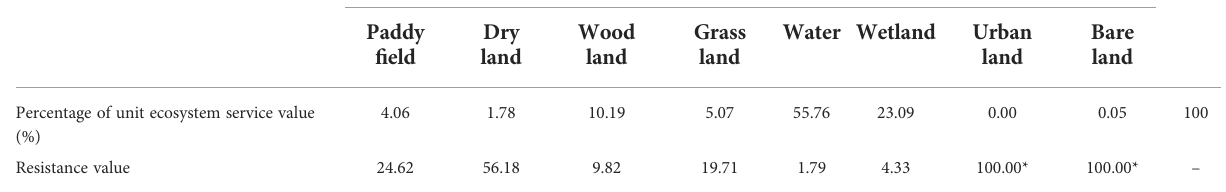
TABLE 4 Landscape ecological resistance value.